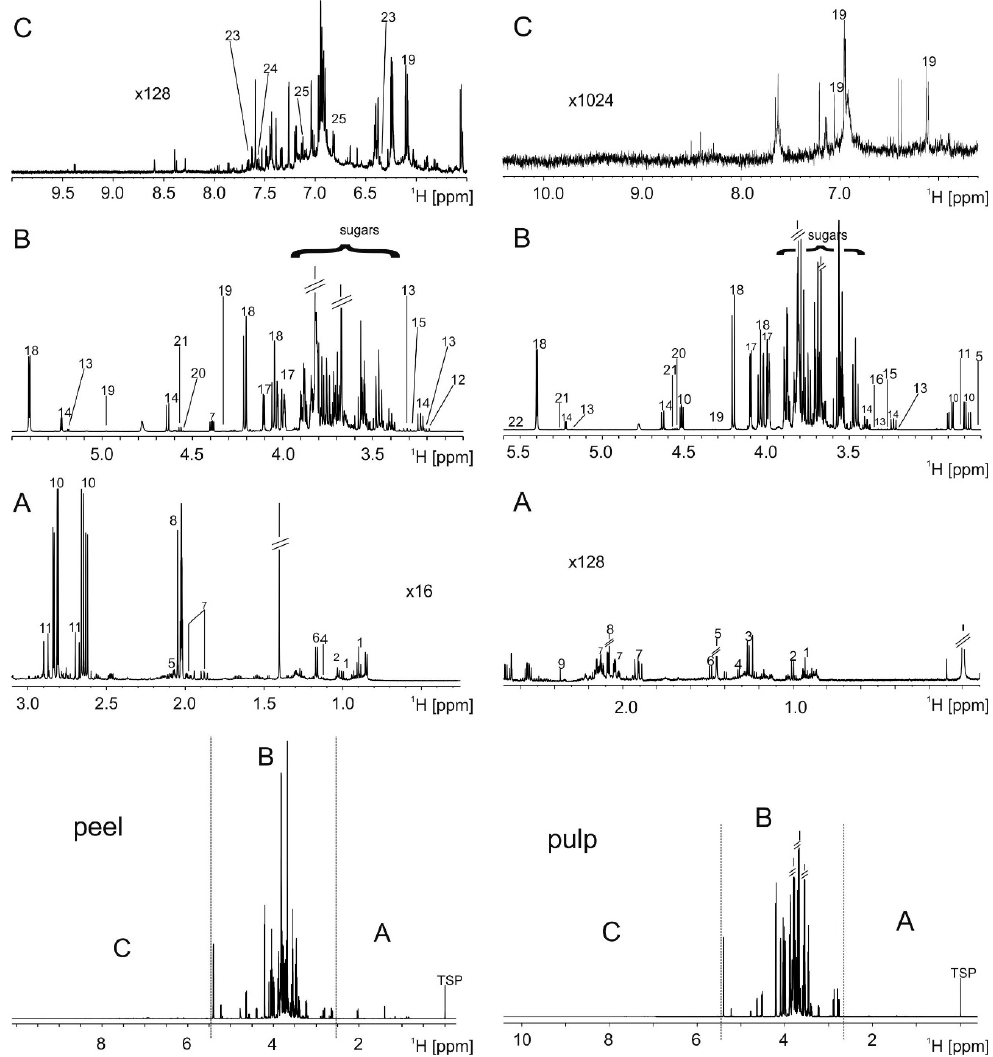
Figure 1. 1 H-NMR spectra of peel ( left ) and pulp ( right ). The bottom panels show the entire spectra. Regions that are magnified in (A–C) are indicated. (A) Amino acid region; (B) sugar region; and (C) aromatic region. Metabolites: 1 isoleucine, 2 valine, 3 rhamnitol, 4 lactate, 5 citramalic acid,